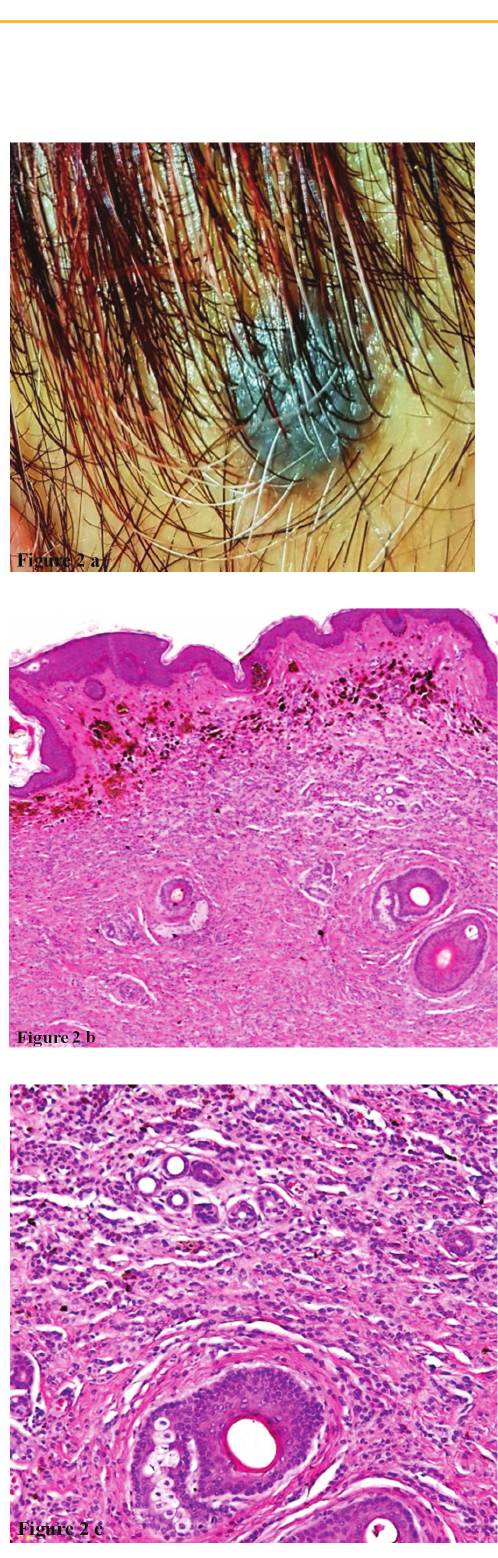
Figure 2: Black well circumscribed congenital melanocytic nevus on the right temple. Figure 2 b at 20 x: Symmetrical pigment laden nevus cells arranged horizontally in the papillary and reticular dermis with maturation and progressive descent; splaying between collagen bundles. Figure 2 c at 40 x: Nevus cells permeating the muscles of hair shafts and blood